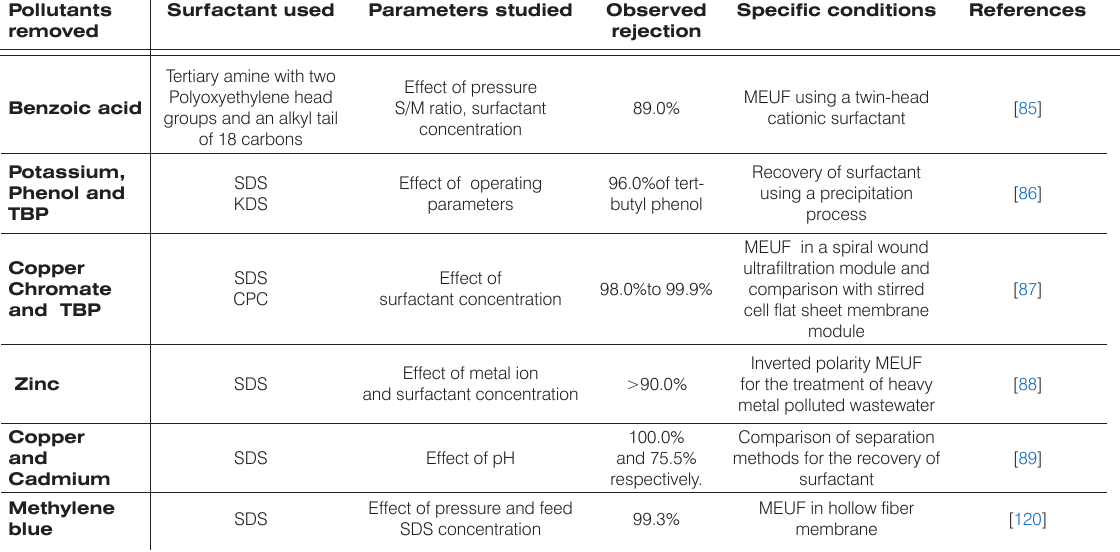
Table 6. Other removals by